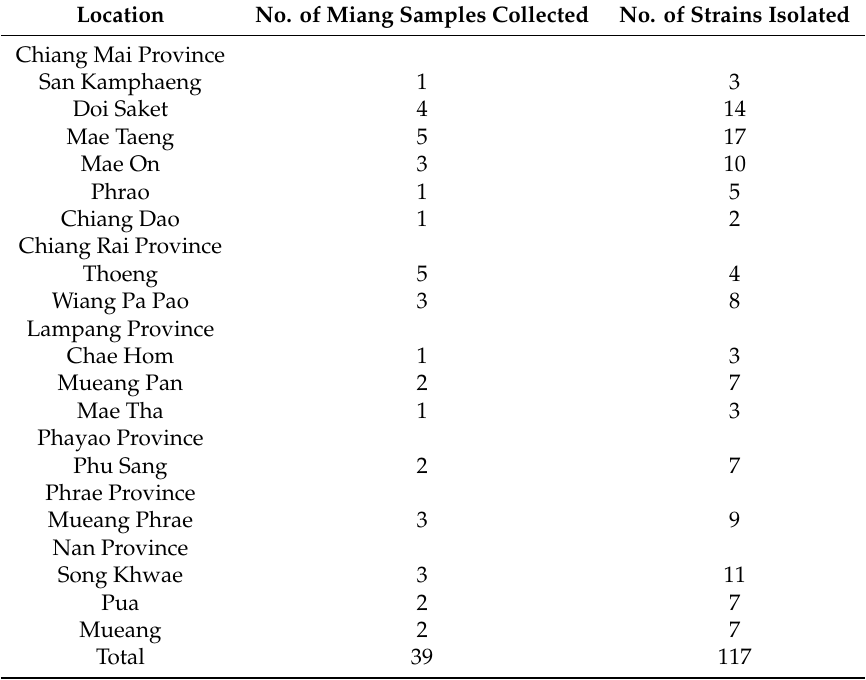
Location No. of Miang Samples